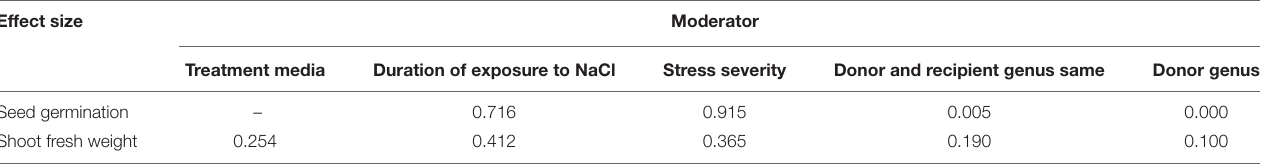
TABLE 4 | Categorical moderators examined for the six summary effects of CBL - transformation that were significantly different from zero Heterogeneity p -values ( p - hetero ) are shown